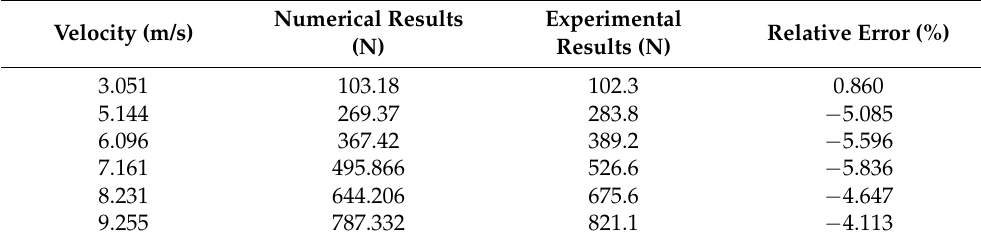
Table 4. Relative error of numerical and experimental resistance values for SUBOFF-AFF-8.